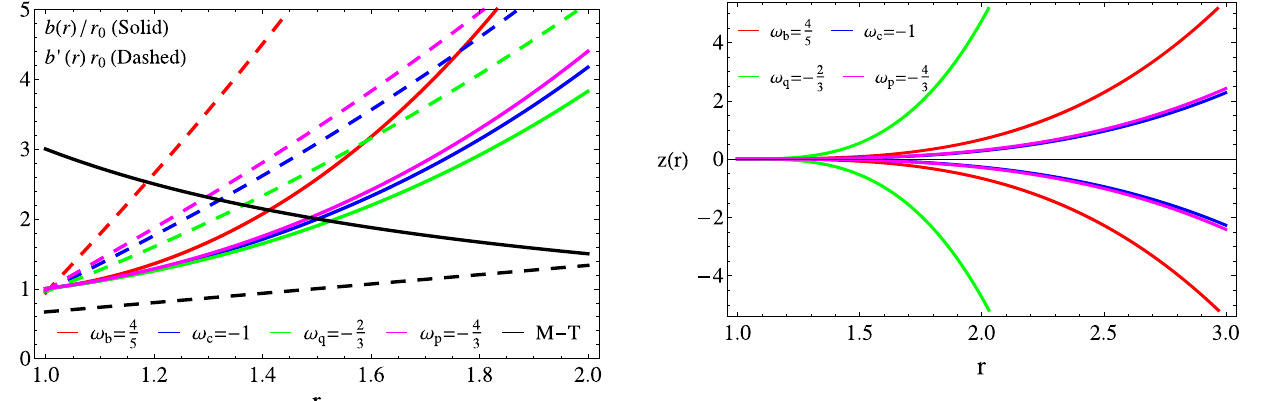
Fig. 3 The figure shows the 2-dimensional wormhole embedding dia- gram for the model #1. The vertical axis has been re-scaled by a factor 10 33